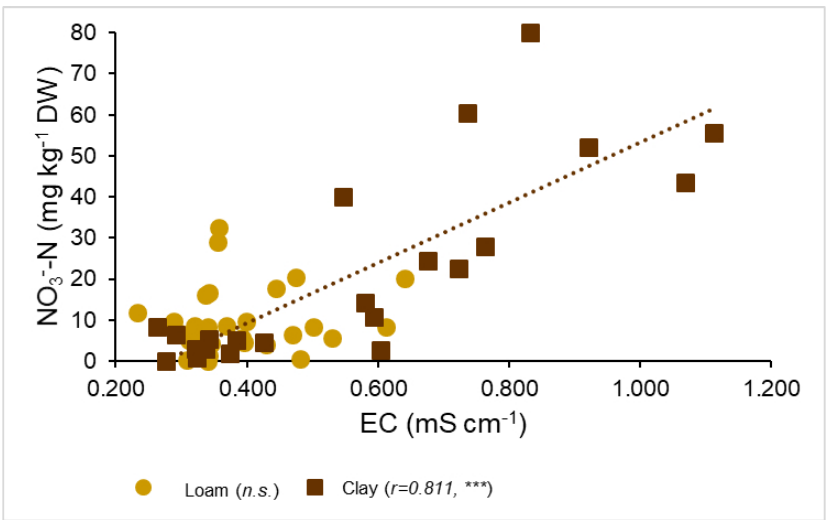
Figure 5. Correlation between electric conductivity (EC) measured by probes and soil nitrate (NO 3 − -N) concentration in loam (circle) and silty-clay-loam soils (data from April to August). *** = effect of treatment significant at p ≤ 0.001.